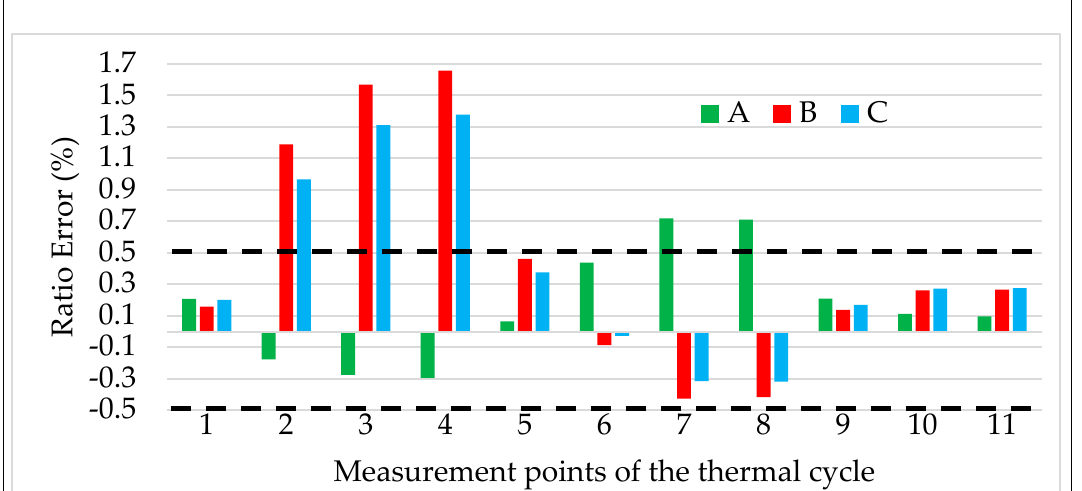
Figure 9. Ratio error vs. temperature for the three LPVTs under test.